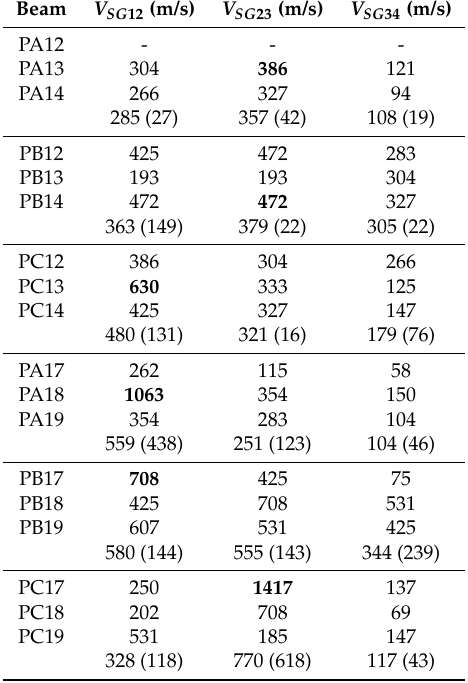
Table 7. Measured crack velocities using the strain gages for the loading rate at 1.77 m/s (PX12, PX13 and PX14) and 2.66 m/s (PX17, PX18 and PX19), the corresponding mean and standard deviations are given in the fourth row of each concrete type. The maximum velocities in each group are marked as bold